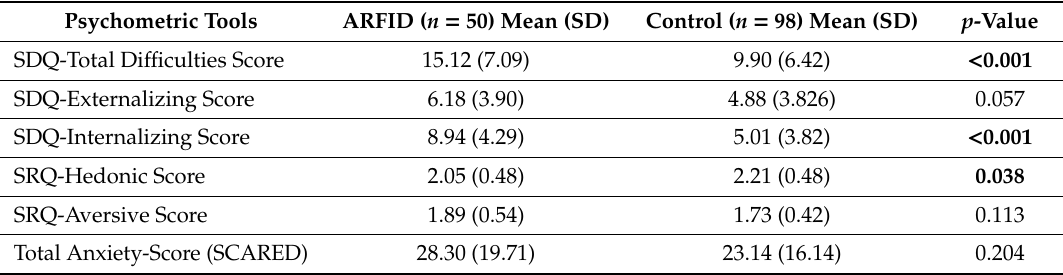
Table 3. Comparison between children with ARFID and control children in noneating related psychometric